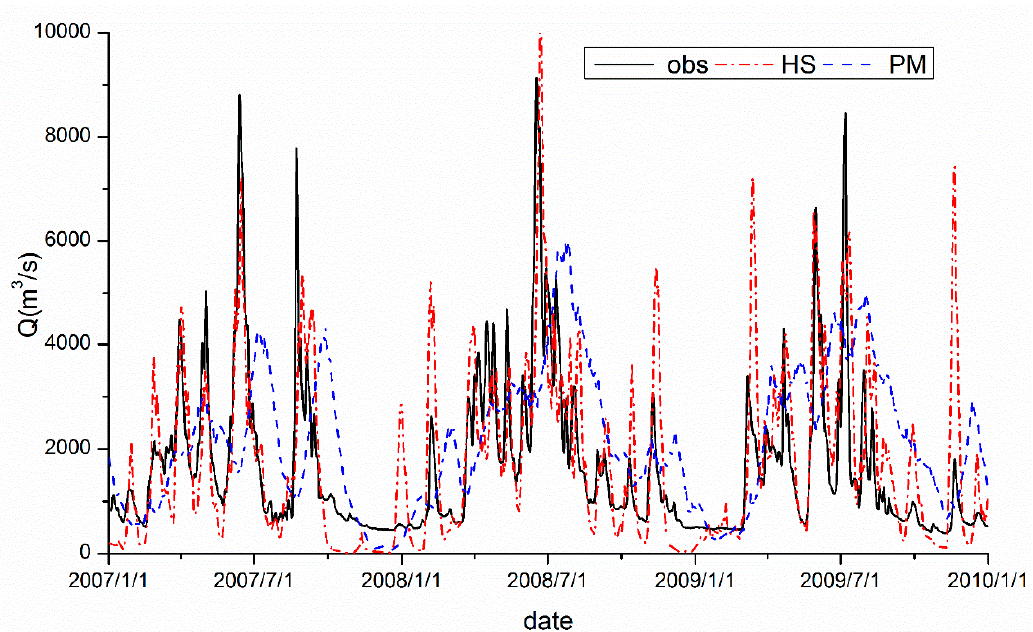
Figure 4. Comparison of simulated streamflow with observed streamflow in validation period from 2007–2009 (obs represents the observed streamflow, HS and PM represent the CREST 3.0 streamflow simulations driven by daily PET estimations from HS and PM methods, respectively). Table 5. Statistical summary of comparison of the observed and simulated streamflow based on HS and PM methods during 2007–2009 at 25 km spatial resolution.